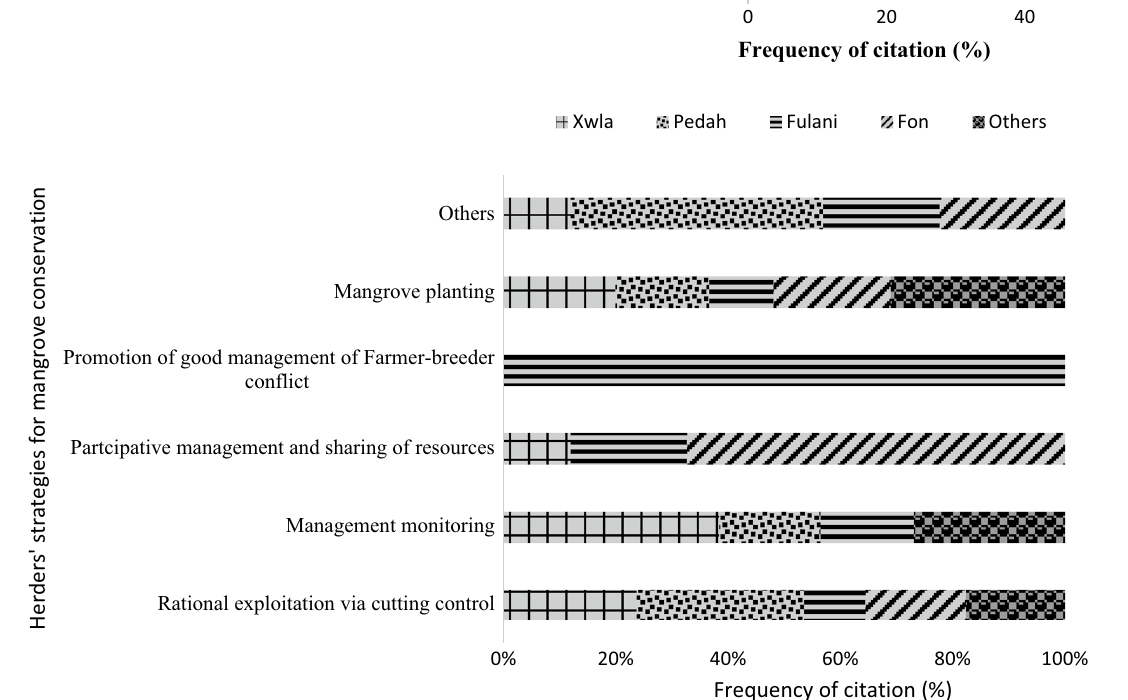
Fig. 5 Herders proposed strategies for the conservation of mangrove forests, accord- ing to mangroves status (degraded or restoring)